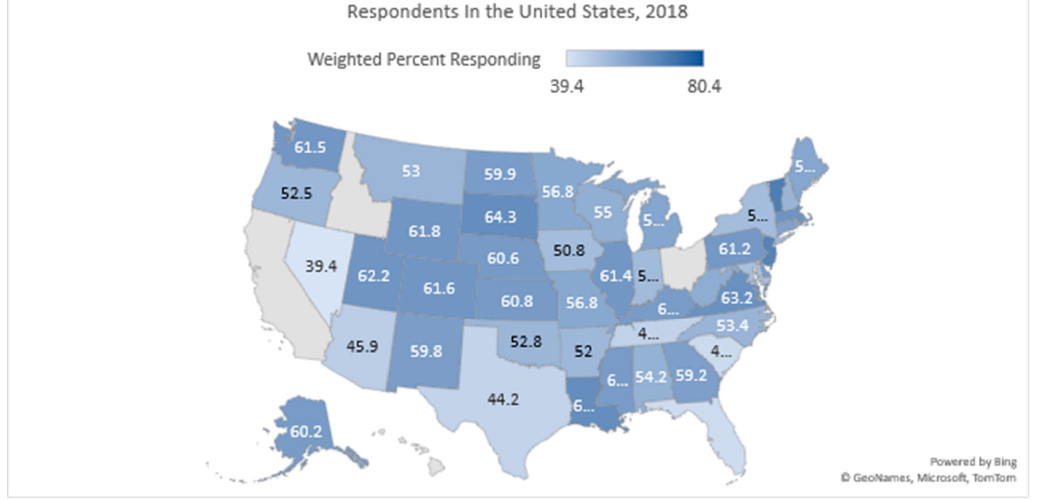
Figure 1. The weighted survey response rate according to different states. Note: The figure represents the weighted survey response rate for all the states in the United States. Each number corresponds to the percentage weighted survey response rate.